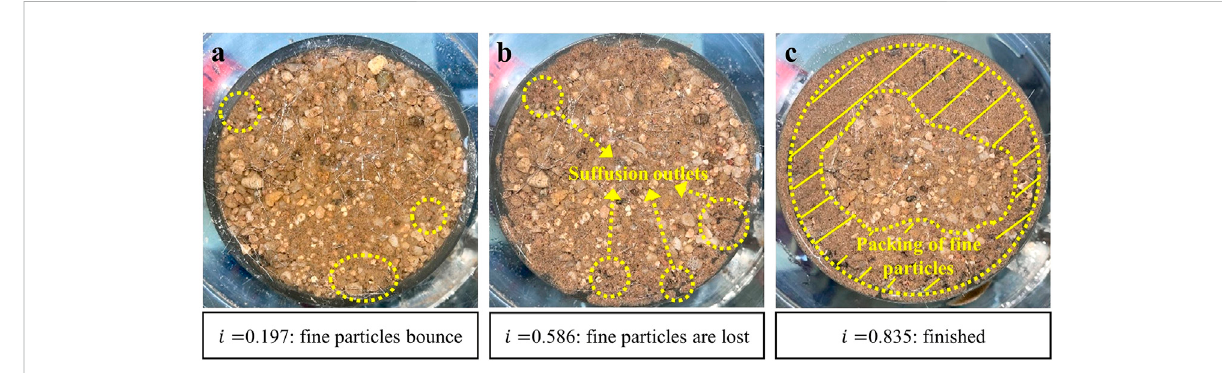
FIGURE 9 Phenomena in test Pa-0.4. (A) i = 0.197: fi ne particles bounce. (B) i = 0.586: fi ne particles are lost. (C) i = 0.835: fi nished.